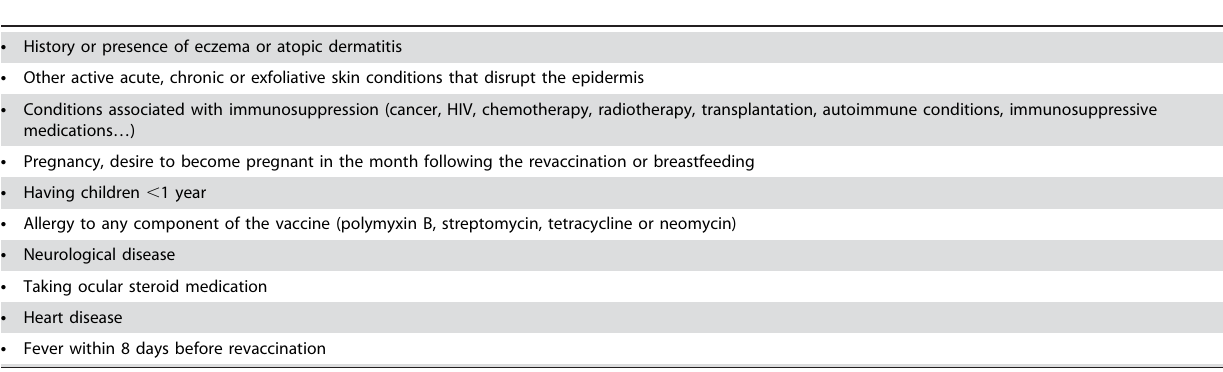
Table 1. Contraindications against vaccination for volunteers and household contacts